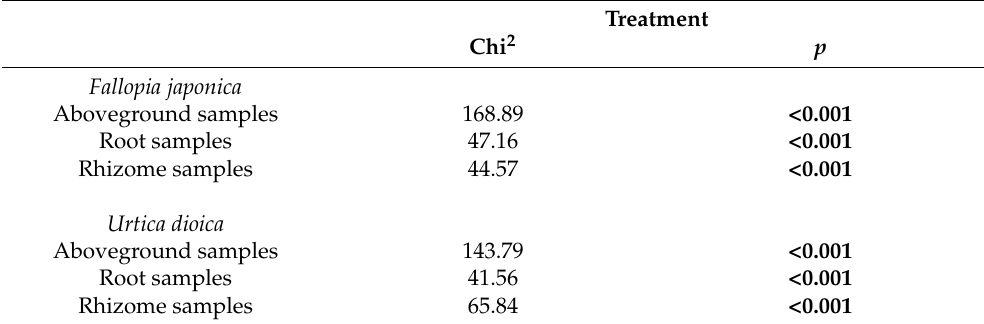
Table 3. Results of the lmer models for both Fallopia japonica and Urtica dioica plant copper content separated by aboveground, root and rhizome samples collected at the end of the second growing season. Chi-squared and corresponding p -value for each analyzed parameter are given. Treatment represents the effect of the copper treatment. Significant values below the level of 0.05 are printed in